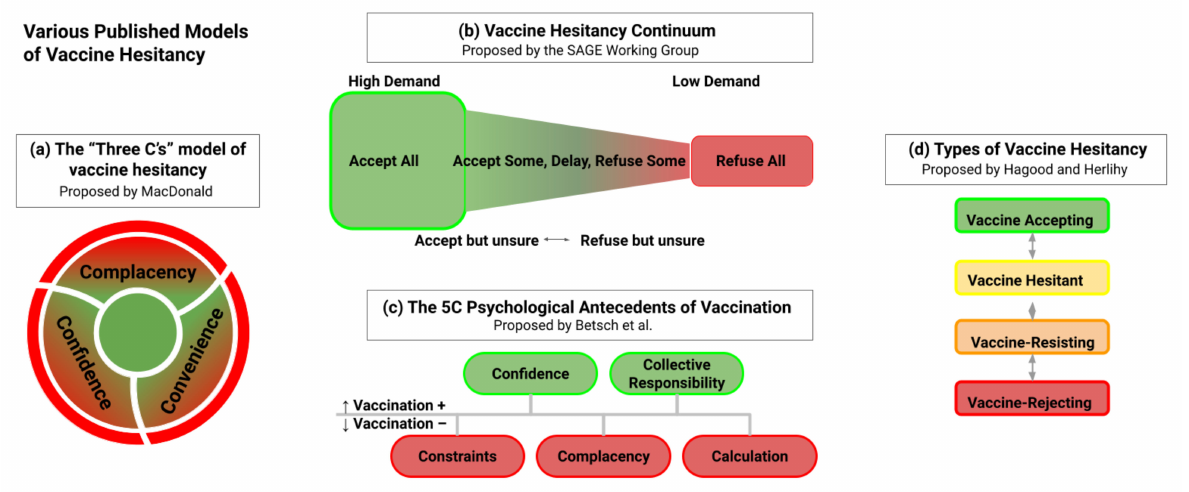
Figure 2. A compilation of the various models proposed to describe vaccine hesitancy. ( a ) The “Three C’s” model of vaccine hesitancy proposed by Macdonald, ( b ) “Vaccine Hesitancy Continuum” proposed by Sage Working Group, ( c ) “The 5C Psychological Antecedents of Vaccination” proposed by Betch et al., and ( d ) “Types of Vaccine Hesitancy” proposed by Hagood and